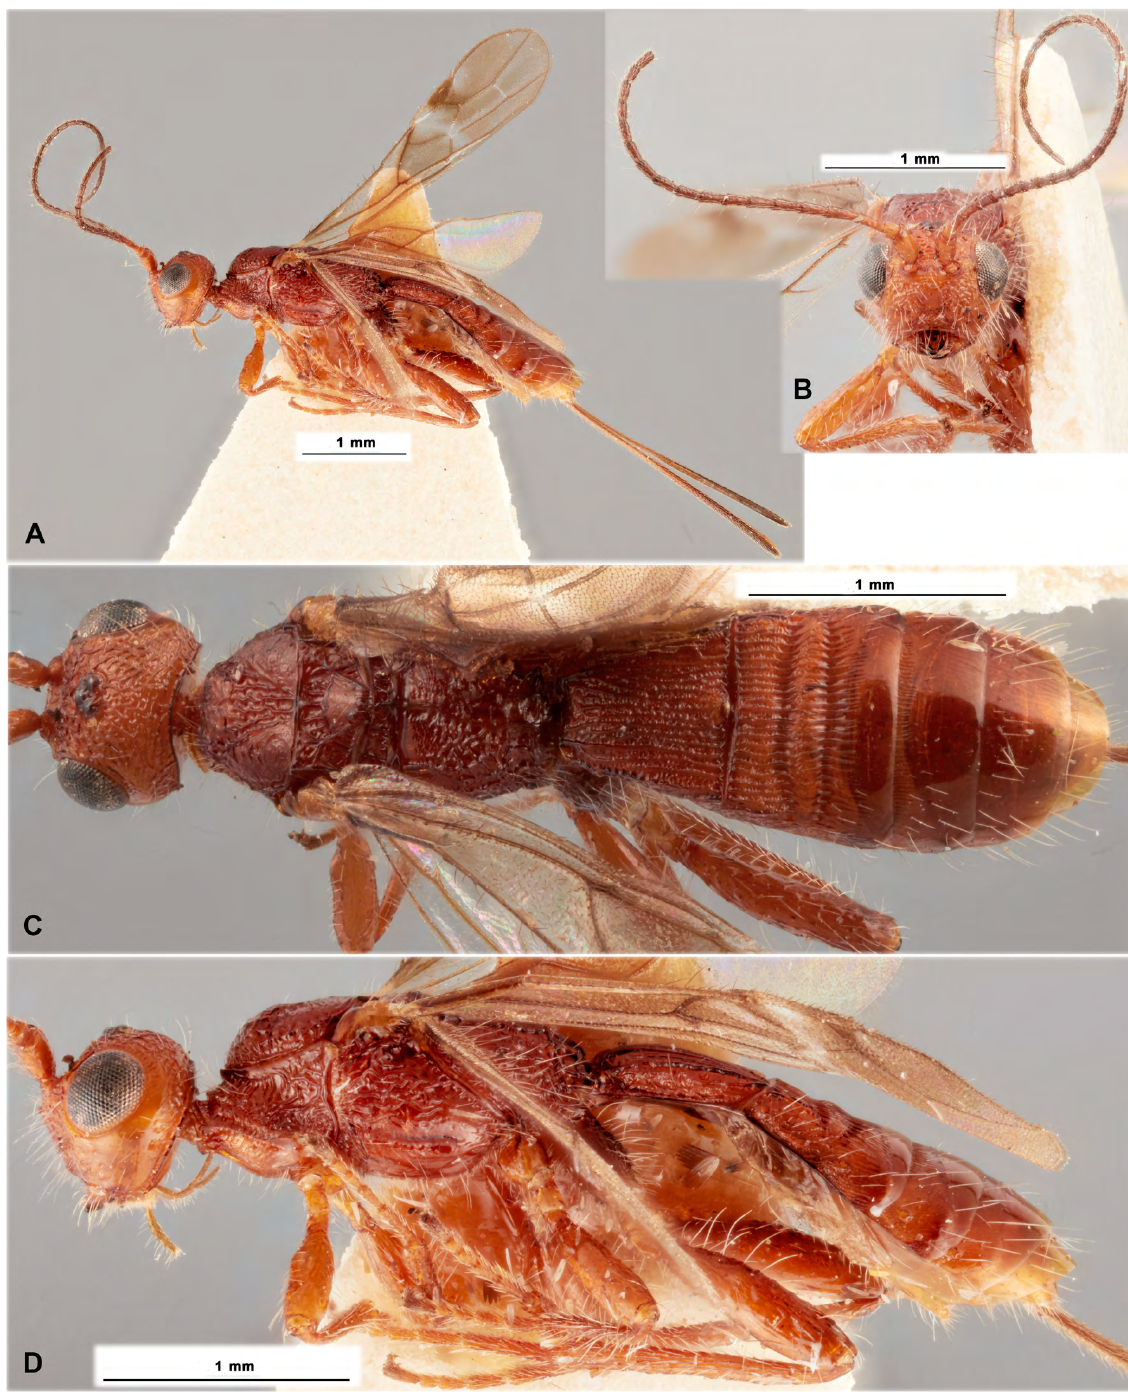
Fig. 26. Neorhaconotus rieki Belokobylskij, Iqbal & Austin, 2004, ♀, holotype, ANIC. A . Habitus, lateral view. B . Head, front view. C . Body, dorsal view. D . Body, lateral view. Image copyright of Dr. Olivia Evangelista, Australian National Insect Collection